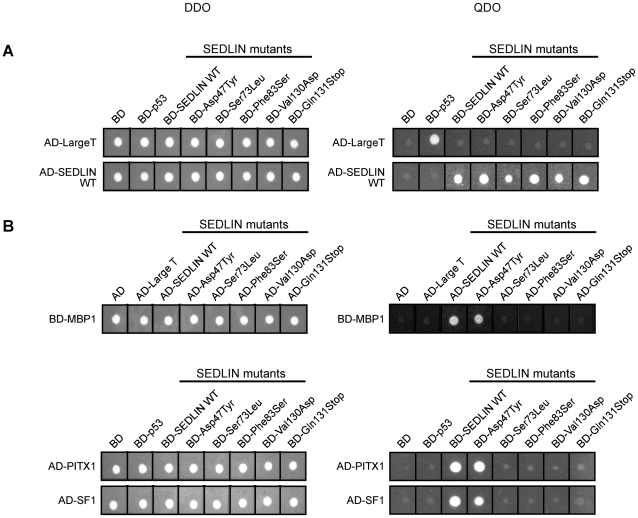
Interactions between SEDLIN, MBP1, PITX1 and SF1 using the yeast two-hybrid assay.Yeast cells, which do not have endogenous expression of SEDLIN, were used to investigate the interactions of wild-type or mutant SEDLIN (Asp47Tyr, Ser73Leu, Phe83Ser, Val130Asp and Gln131Stop) with wild-type SEDLIN, MBP1, PITX1 or SF1. The yeast reporter strain AH109 was used, and p53 and the SV40 large T antigen, which are known to interact [27], were used as a positive control. The yeasts were transformed with the vectors containing: (A) wild-type SEDLIN in pGADT7-AD (AD-WT) and either wild-type or mutant SEDLINs in pGBKT7-BD (BD-WT, BD-Asp47Tyr, BD-Ser73Leu, BD-Phe83Ser, BD-Val130Asp or BD-Gln131Stop). (B) wild-type and mutant AD-SEDLINs or BD-SEDLIN and each of the transcription factors BD-MBP1, AD-PITX1, AD-SF1. Yeast growth was monitored for 48 hrs after spotting and incubation at 30°C using either double drop out, DDO (Leu-Trp-), media as a control or quaternary drop out, QDO (Leu-Trp-Ade-His-), media in which the growth is dependent on the physical interaction between BD-SEDLIN and AD-transcription factors, or AD-SEDLIN and the BD-transcription factor. The wild-type SEDLIN interacts with wild-type SEDLIN and all of the mutant SEDLIN proteins, consistent with the proposed model for the formation of homodimers. However, the MBP1, PITX1 and SF1 fusion proteins, which interact with the wild-type SEDLIN, interacted only with the mutant Asp47Tyr SEDLIN, but not with the mutant Ser73Leu, Phe83Ser, Val130Asp and Gln131Stop SEDLINs.